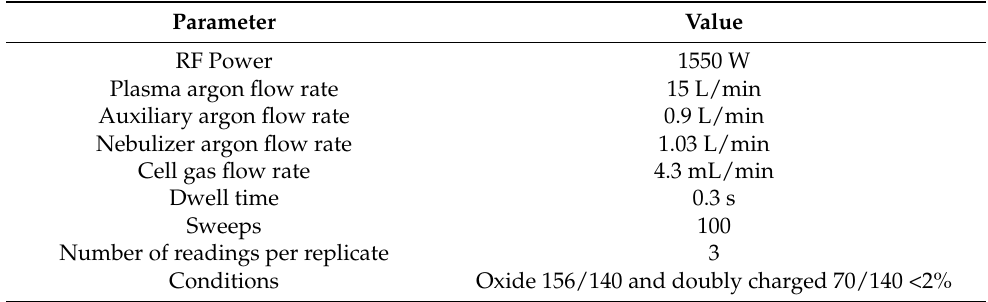
Table 7. Instrumental conditions of ICP-MS.